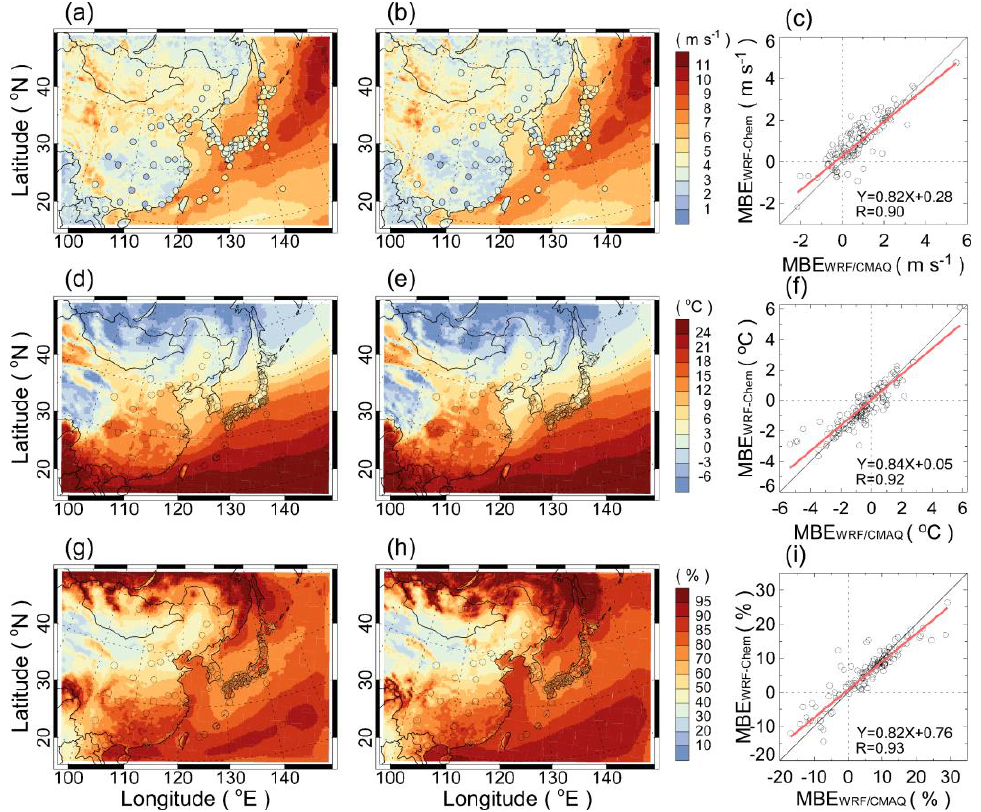
Figure 3. Comparison of the meteorological fields of ( a – c ) 10-m wind speed, ( d – f ) 2-m temperature, and ( g – i ) relative humidity simulated by the WRF-Chem (left panels) and the WRF/CMAQ (middle panels). The measured data were overlaid by color-coded circles and the mean bias errors ( MBE ) were compared between the models (right panels).